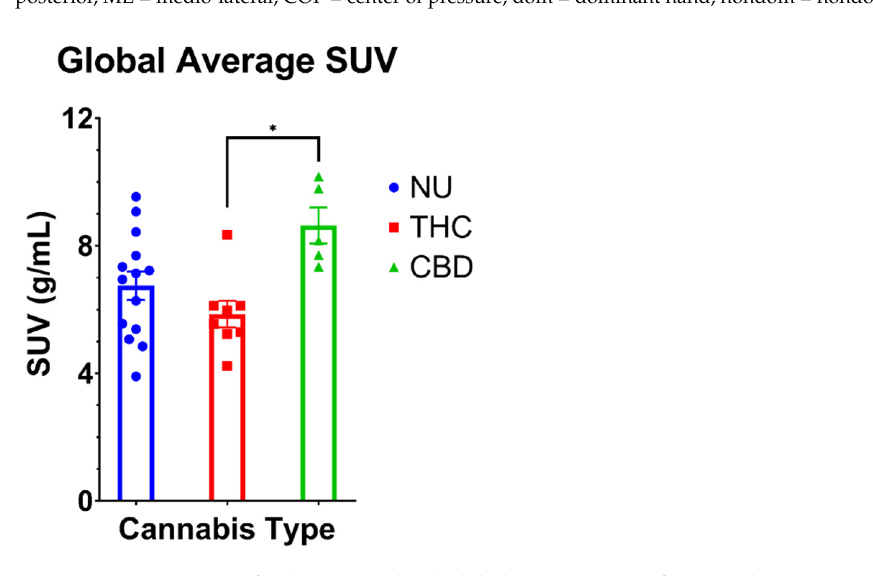
users and CBD users. Data are mean ± SEM. * CBD users have glucose hypermetabolism ( p = 0.02,